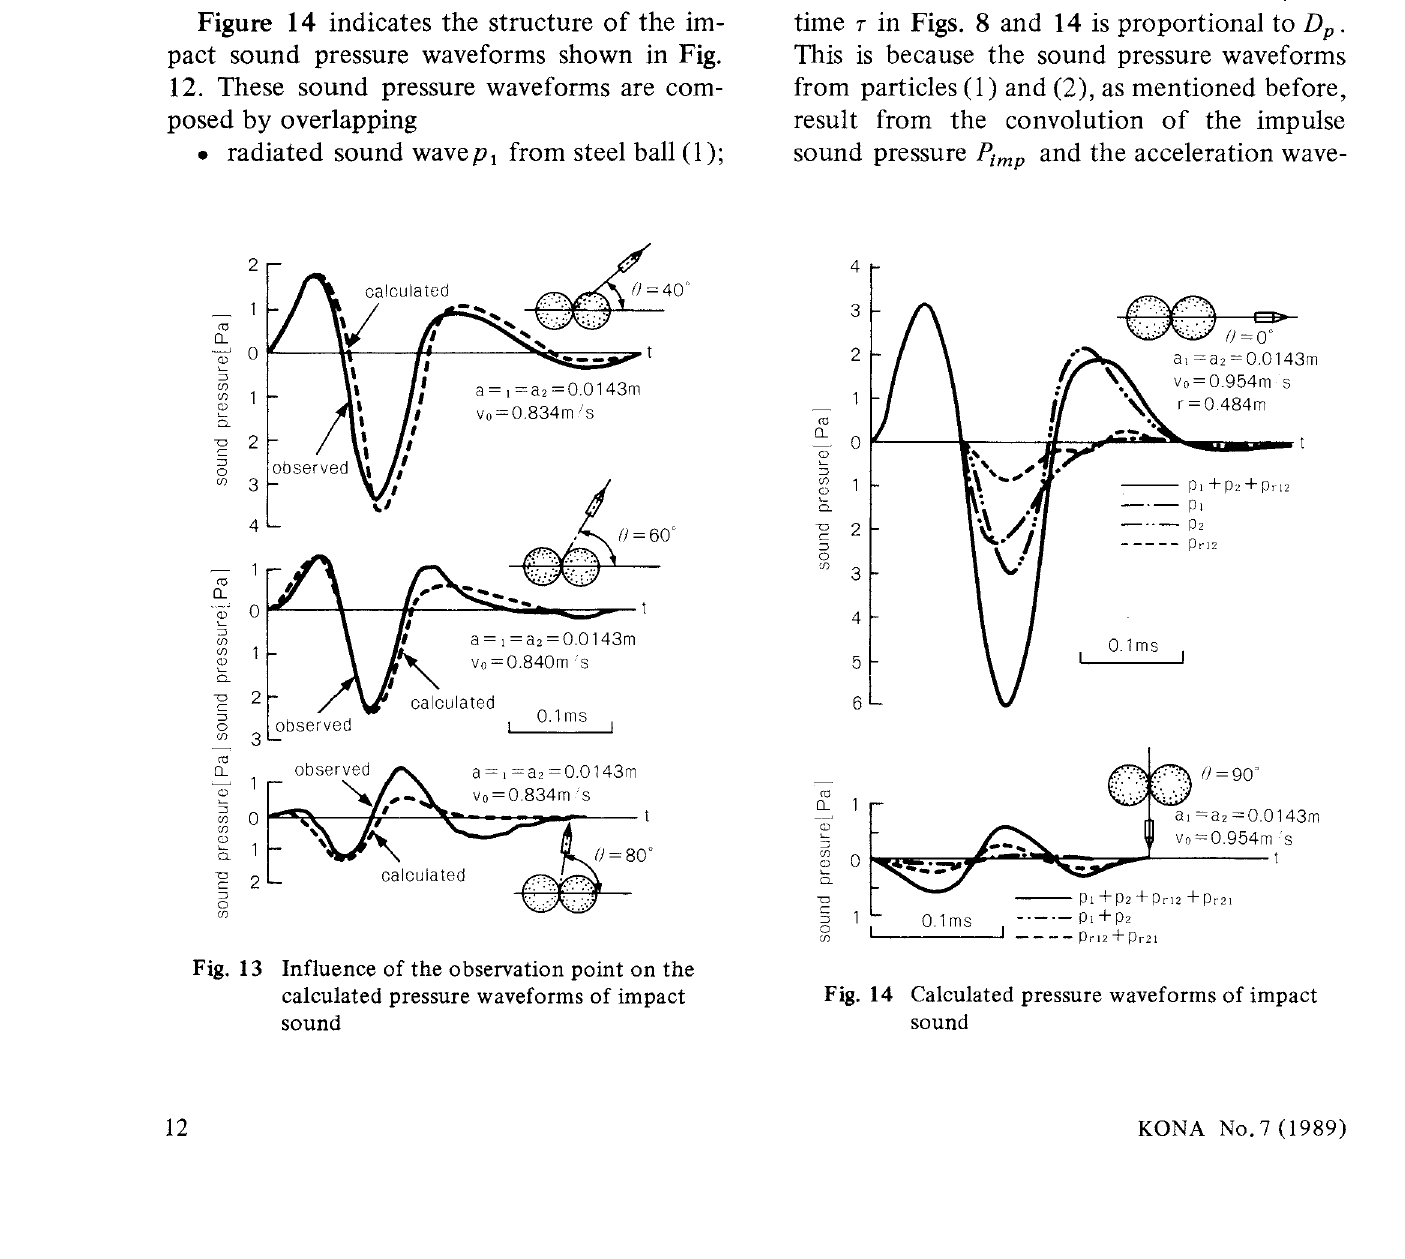
Fig. 13 Influence of the observation point on the calculated pressure waveforms of impact sound